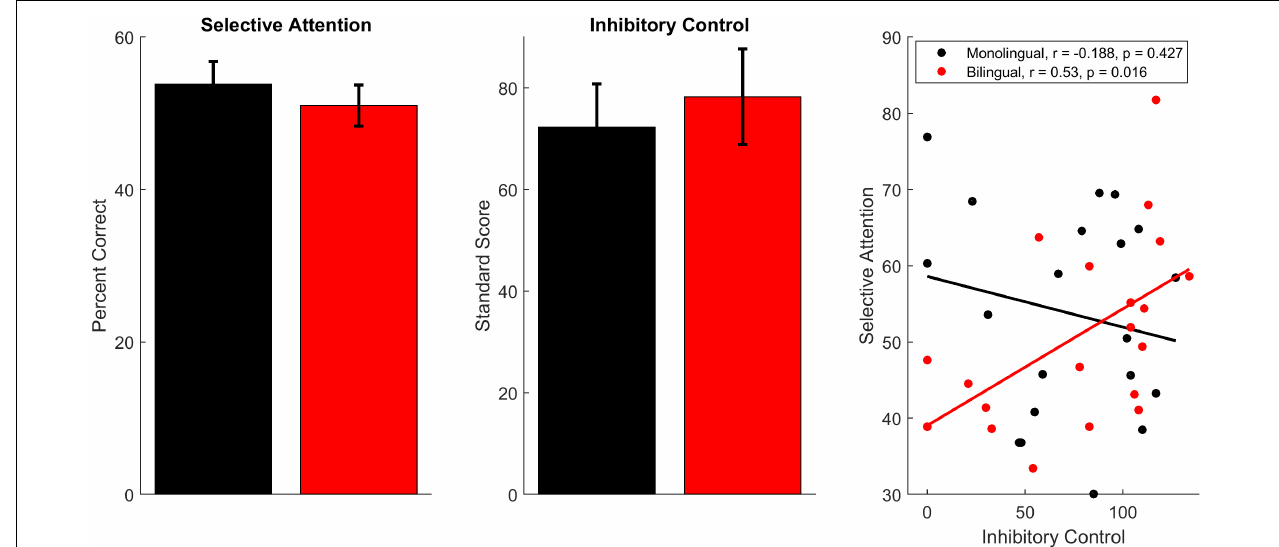
FIGURE 2 | Behavioral performance on the selective attention and inhibitory control tests. Bilinguals (red) and monolinguals (black) performed equivalently on both of these measures. However, performance on these measures was only correlated in bilingual participants. Error bars display standard error of the mean.